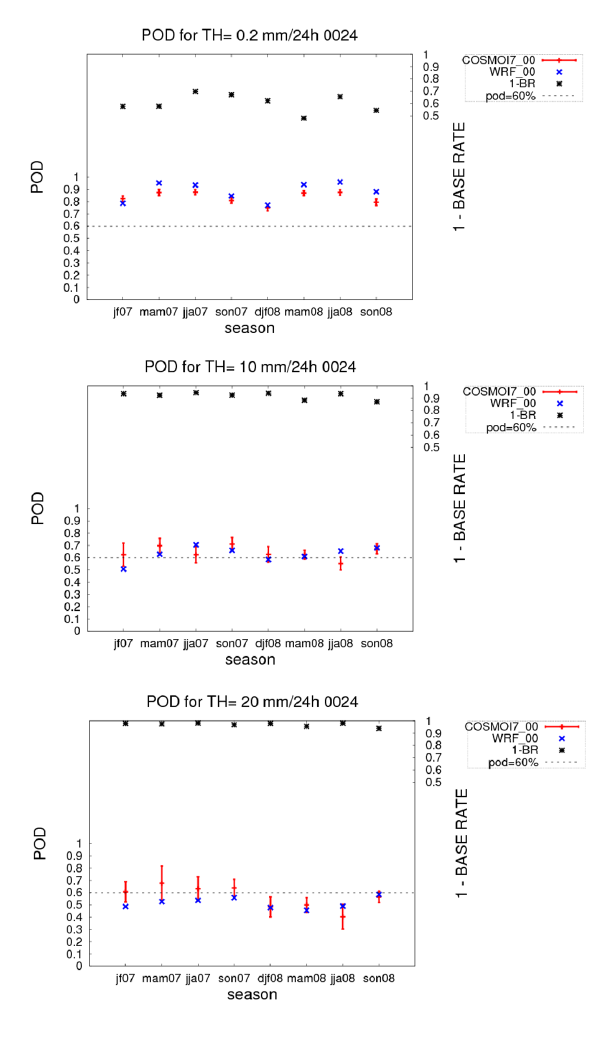
Fig. 7. Seasonal trend: POD vs. increasing threshold of forecast. The dashed red lines and the blue daggers represent COSMO-I7 and WRF, respectively. The Base Rate (stars) is plotted for each